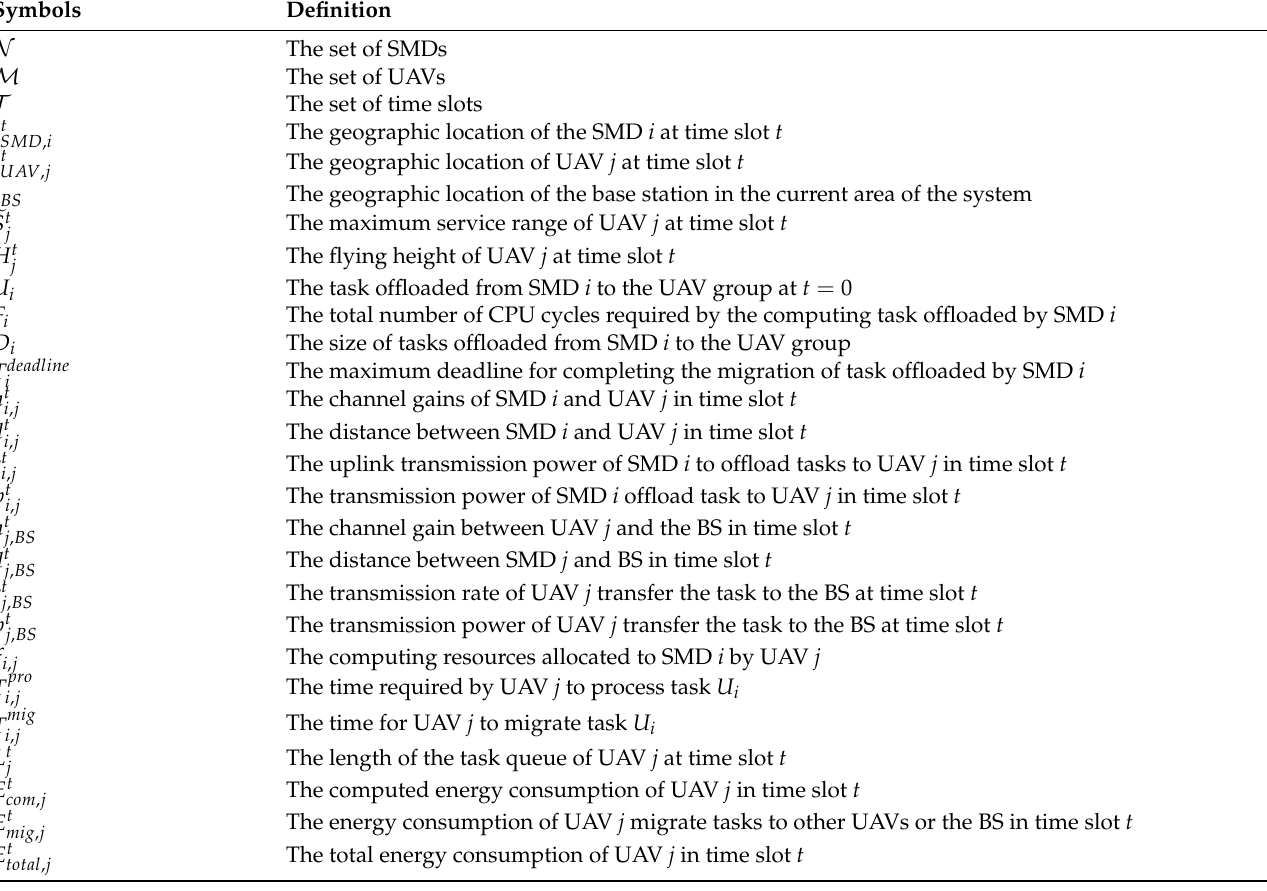
Figure 1. Overall architecture of the system. Table 1. Definition of main